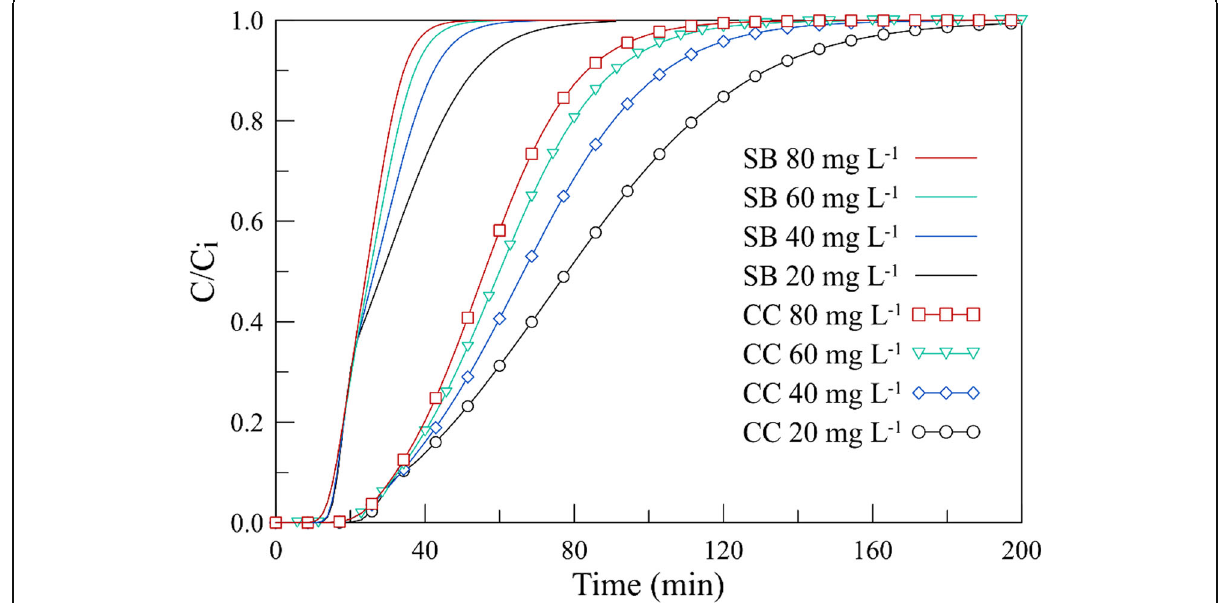
Fig. 6 Breakthrough curves of ACT adsorption on SB and CC by varying the initial